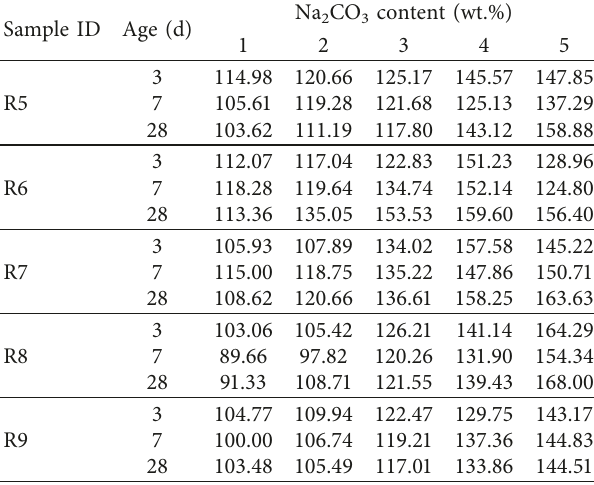
Table 3: Relative strengths of samples with the Na compared to the strength of samples without